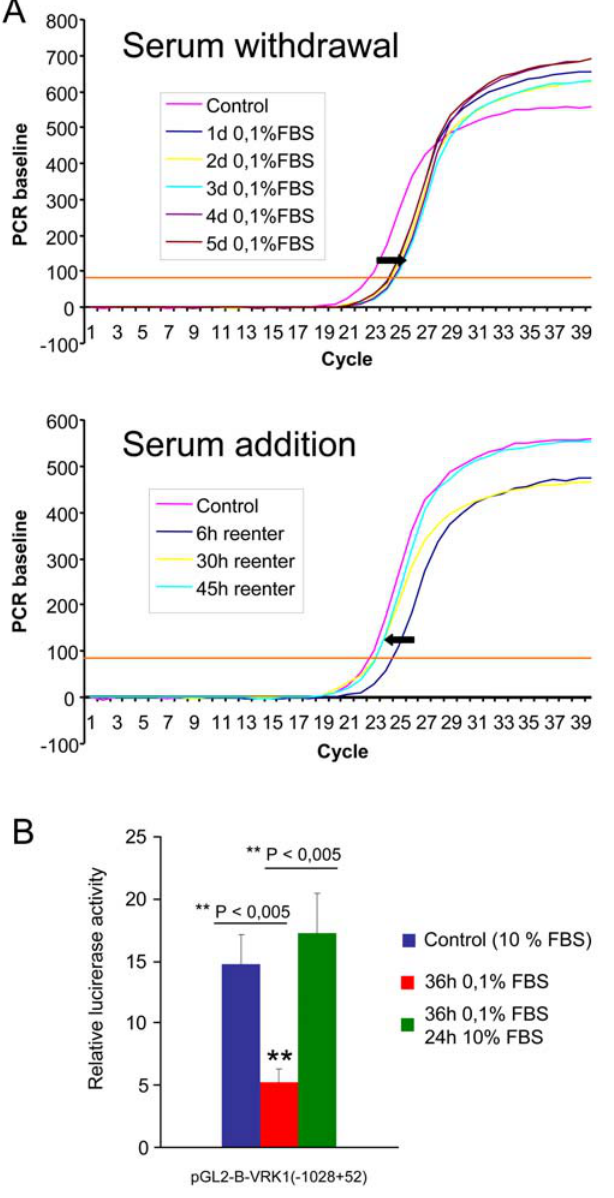
Figure 2. Changes in VRK1 RNA level upon serum withdrawal or readdition to the culture. (A). Quantification of the VRK1 gene expression in WS1 fibroblasts at different time points upon serum withdrawal (top) and serum readdition to the cell culture (bottom) which was previously serum-deprived for five days. These experiments were independently performed three times. (B). Regulation of the human proximal promoter of human VRK1 by serum. WS1 cells were transfected with plasmid pGL2-B-VRK1( 2 1028 + 52). The luciferase activity was determined under different experimental conditions. Control activity is that of cells in the continuous presence of serum. The result is the mean of three experiments. doi:10.1371/journal.pone.0001642.g002 Figure 3. Cell cycle gene expression induced by removal or three days there was noticeable drop in endogenous VRK1 protein levels that was almost complete by day five, which was accompanied by an almost complete reduction in cell division as shown, both, by cell number or total mass. In the culture there were fewer cells after five days of specific siRNA treatment (Fig. 7B).